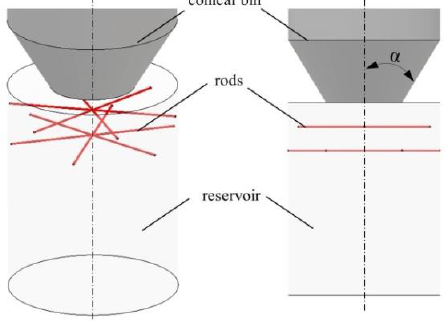
Fig. 1. Main components of the snowstorm